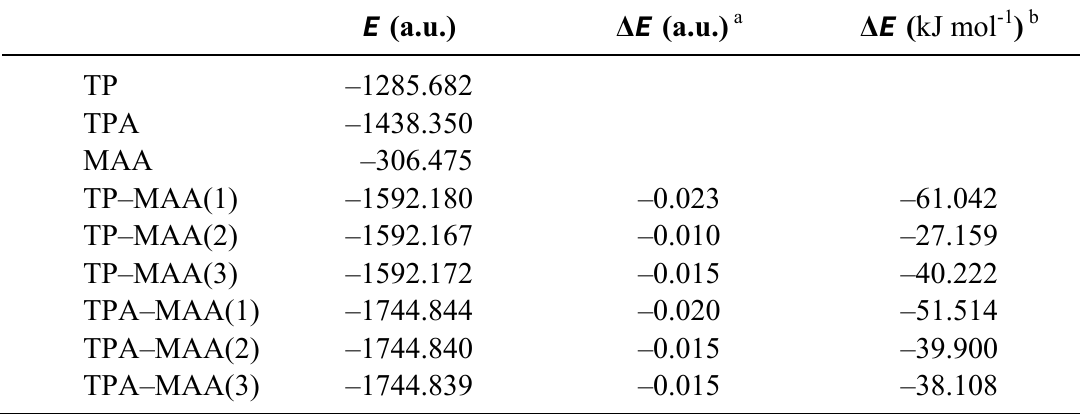
Table 1. Summary of the interaction energies of template-monomer